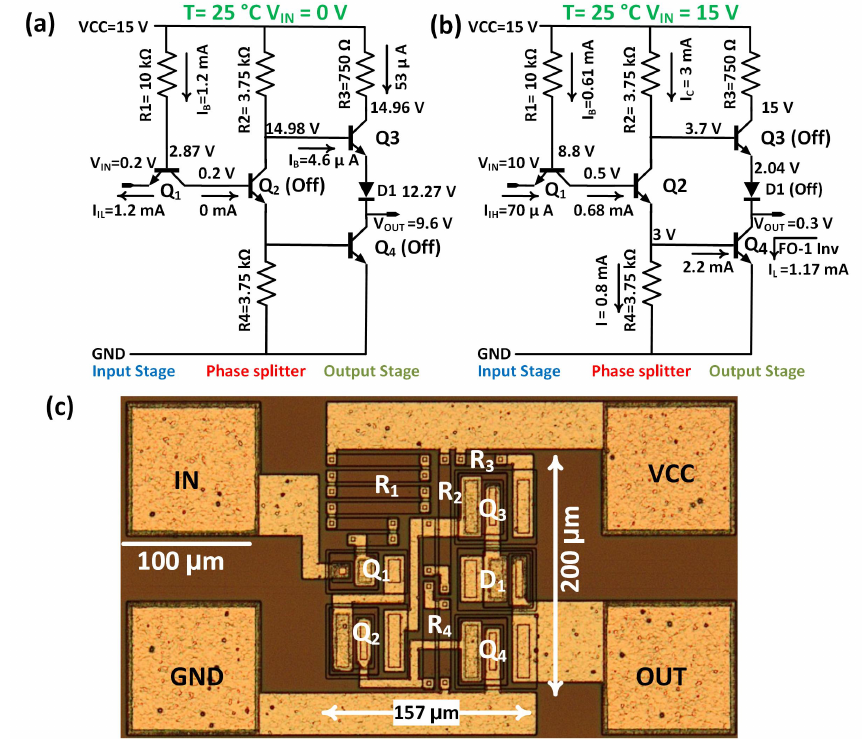
Figure 10. SiC TTL inverter circuit diagram with node currents, voltages and micro-photograph ( a ) the output-high state ( b ) the output-low state ( c )